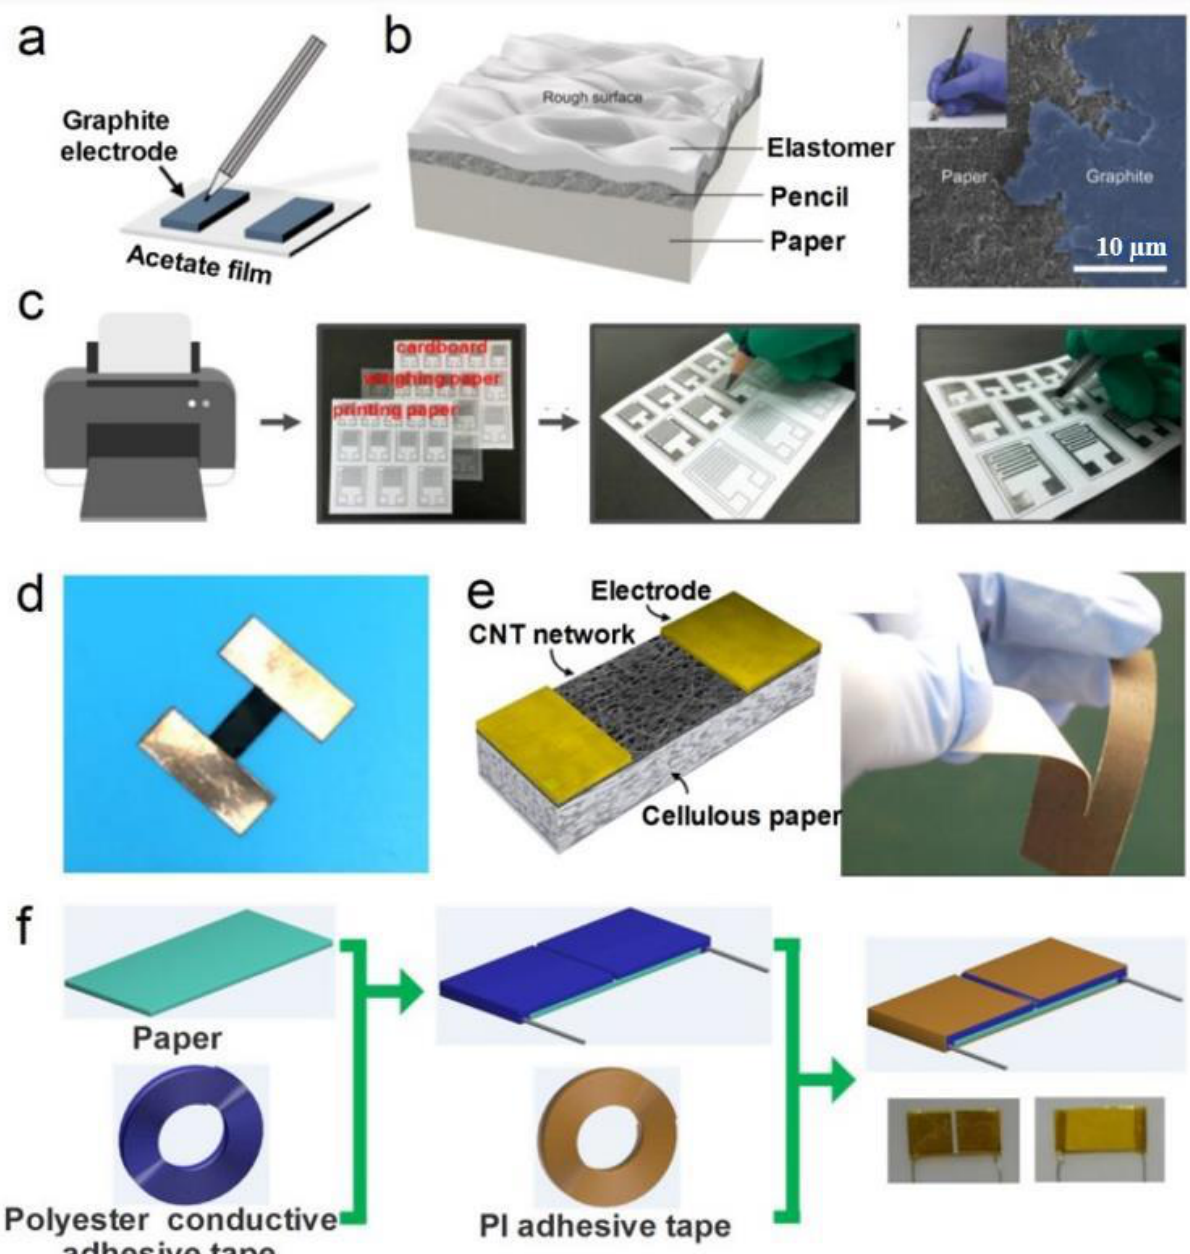
Figure 19. ( a ) Fabrication schematic illustration of the pencil electrodes. Reprinted with permission from [180]. Copyright 2018: American Chemical Society; ( b ) Schematic illustration of the microstructure-like randomly rough surface. Reprinted with permission from [301]. Copyright 2017: Wiley-VCH; ( c ) Fabrication schematic illustration of the PB electrodes using drawing method. Reprinted with permission from [176]. Copyright 2017: American Chemical Society; ( d ) Photograph of the PB humidity sensor based on copper electrodes. Reprinted with permission from [178]. Copyright 2019: American Chemical Society; ( e ) Schematic illustration of the humidity sensor built on a cellulose paper substrate using copper electrodes. Reprinted with permission from [175]. Copyright 2012: American Chemical Society; ( f ) Fabrication process of the PB humidity sensor using pasting method. Reprinted with permission from [28]. Copyright 2019: American Chemical Society. (Reprinted with permission from [26]. Copyright 2020: ACS).